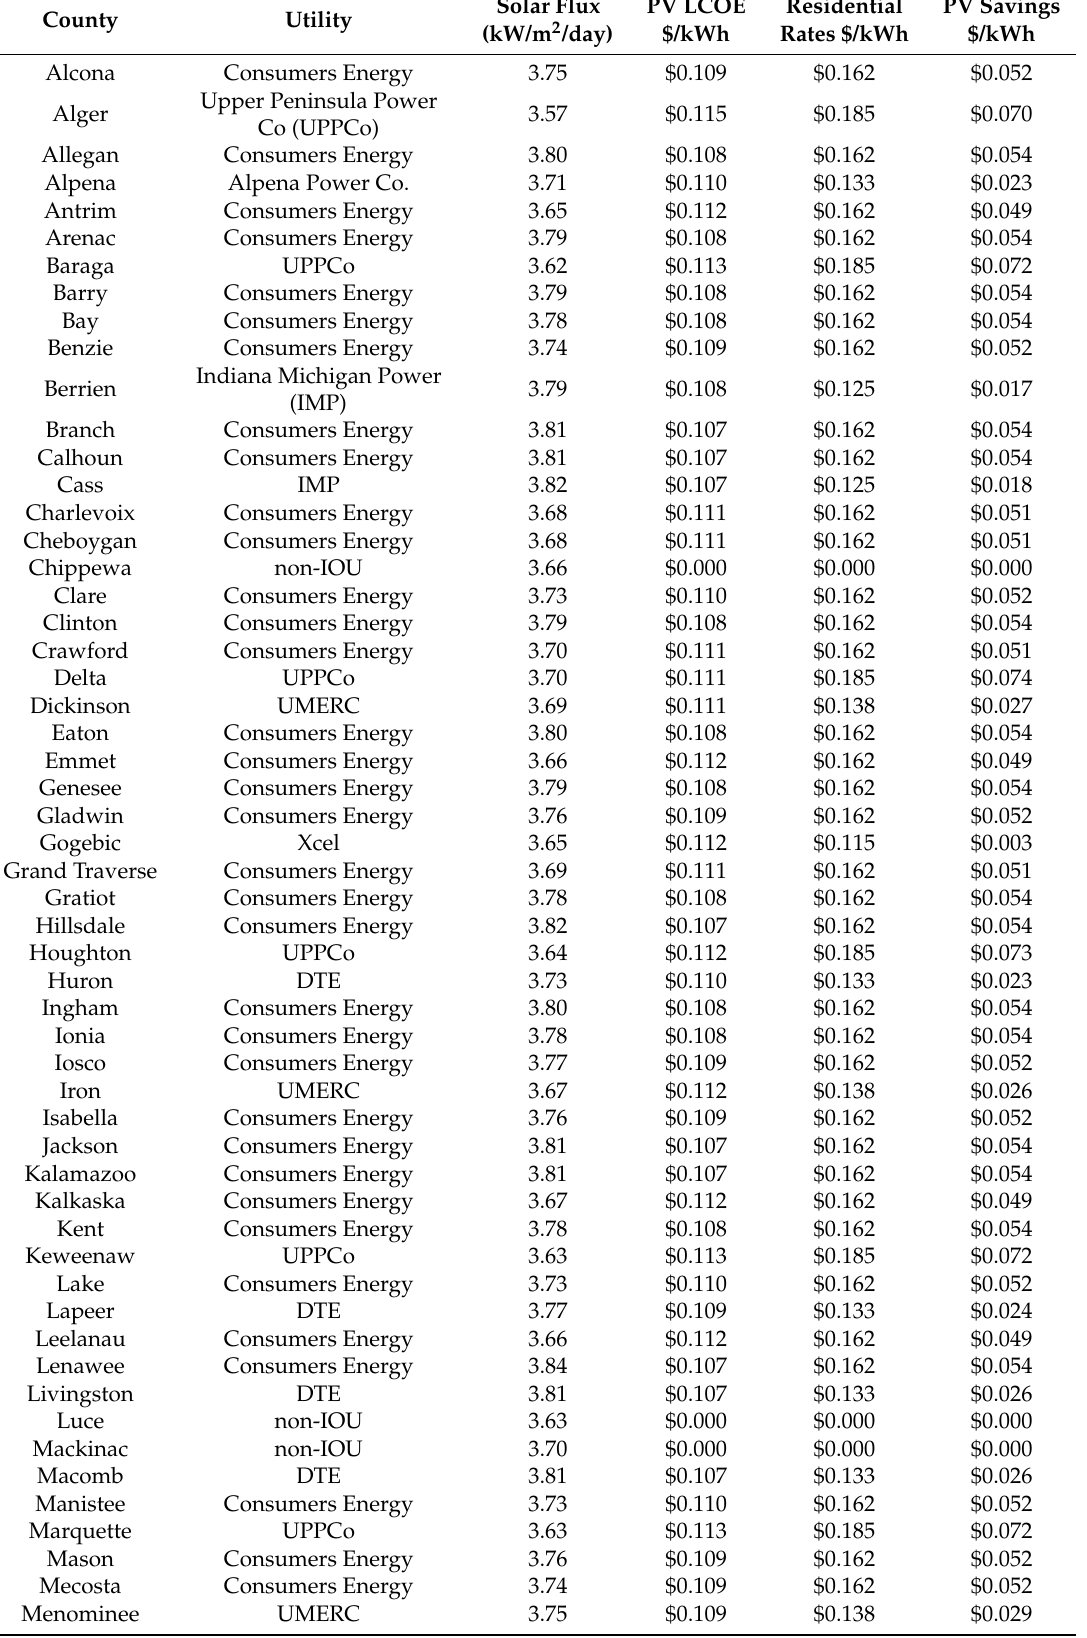
Table 1. Michigan County solar photovoltaic (PV) savings for residential systems breakdown per